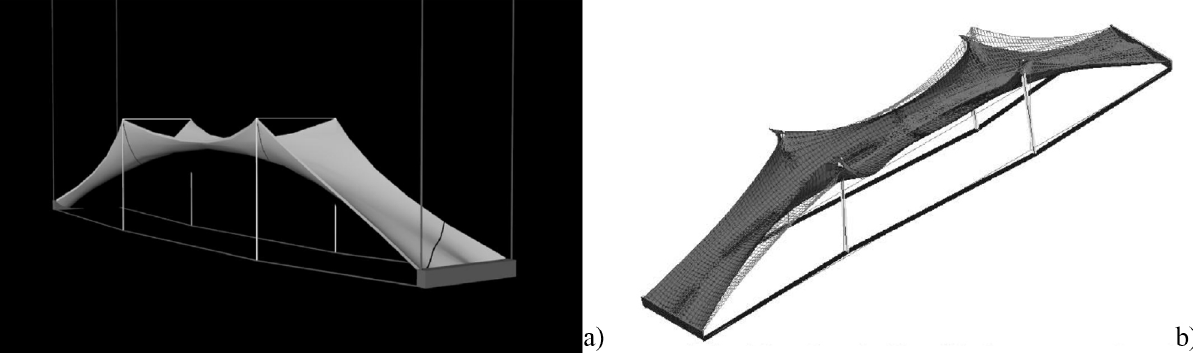
Figure 7: Stay-in-place, self-supporting formwork made of ferrocement. (a) setting-in-place by crane; (b) checking its buckling